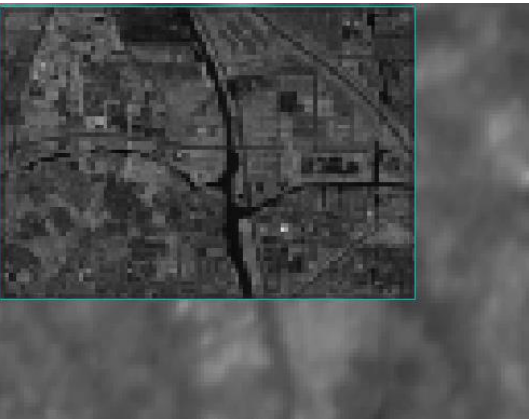
Figure 4. Without RPC correction of July